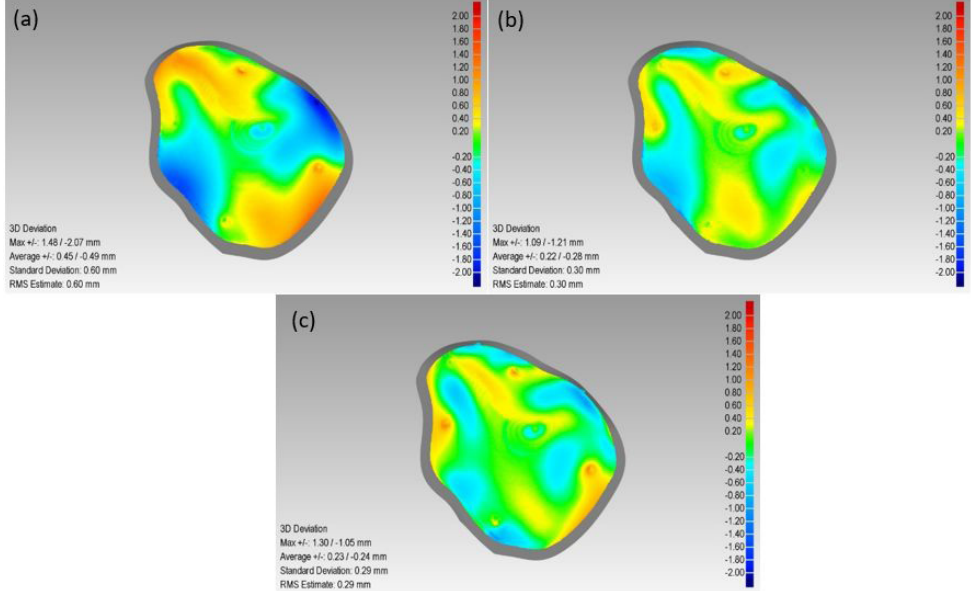
Figure 7 . (a) TT of 480 ºC ; (b) TT of 540 ºC ; (c) TT of 595 ºC.